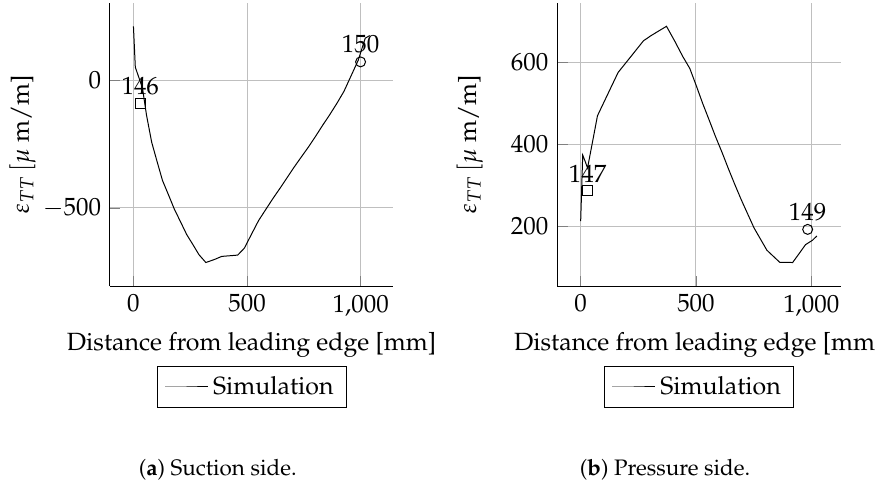
Figure A38. Strain comparison ε LL at radial position R = 17,000 mm for Mymax load